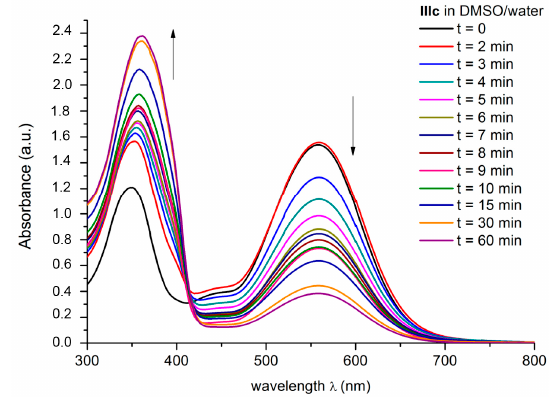
Figure 9 . Monitoring of the evolution of the absorption spectra of dye IIIc in DMSO after addition of 2% of water. Molecules 2016 , 21 , 1227 16 of 24